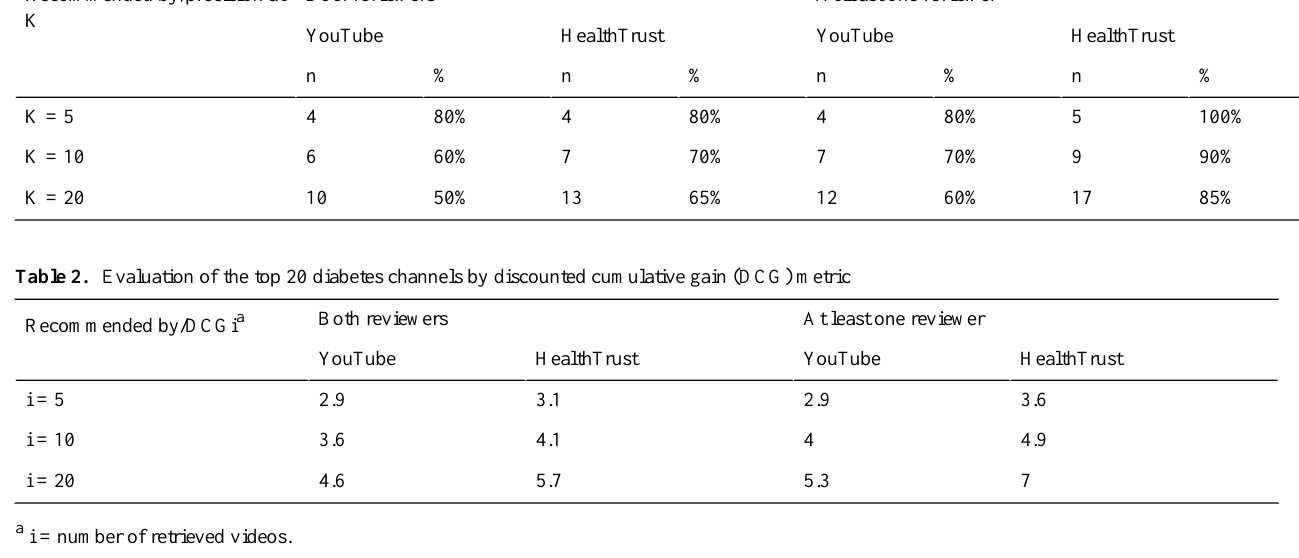
Table 1. Evaluation of the top 20 diabetes channels by precision at K metric K